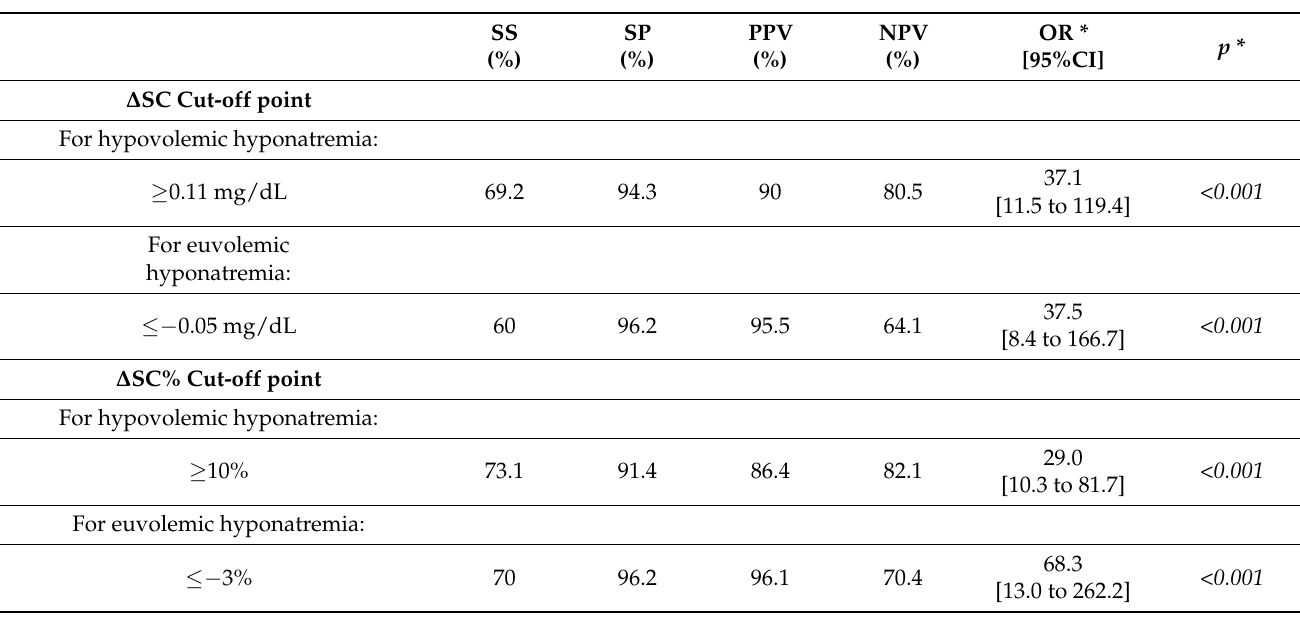
optimal cut-off points of ∆ SC and to classify patients as hypovolemic or euvolemic.